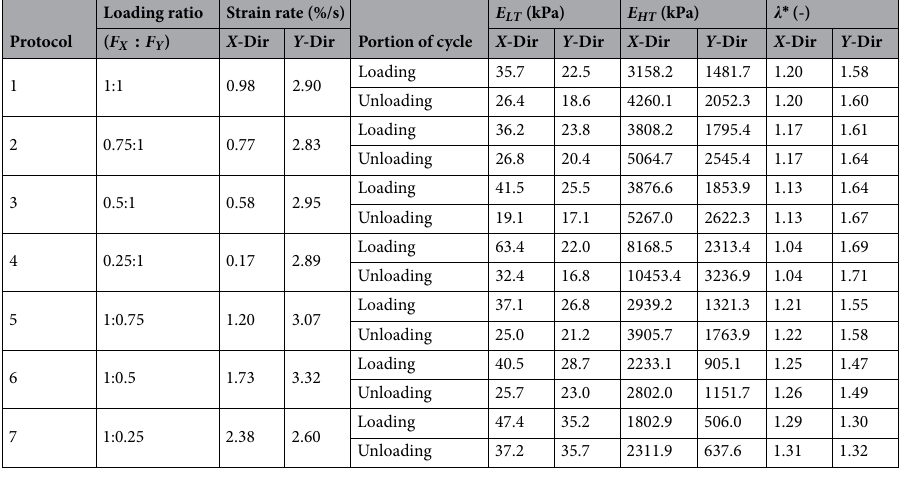
Table 1. Experimental setups and quantified mechanics-related parameters for each of the seven biaxial tension protocols, showing loading ratio ( F X : F Y ), strain rate (%/s), portion of cycle, low-tensile modulus ∗ ( E LT ), high-tensile modulus ( E HT ) and index of extensibility ( (cid:31)